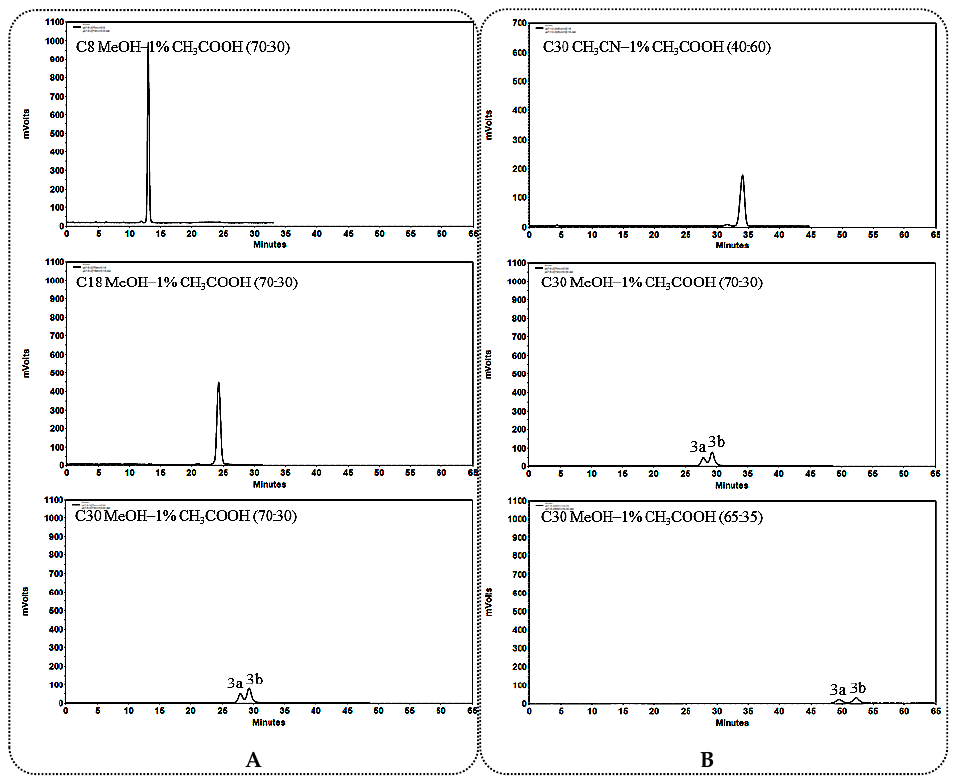
Figure 4. ( A ) Chromatograms of 3a and 3b separated on C 8 , C 18 , C 30 columns; ( B ) Chromatograms of 3a and 3b separated on the C 30 column in different solvent systems.